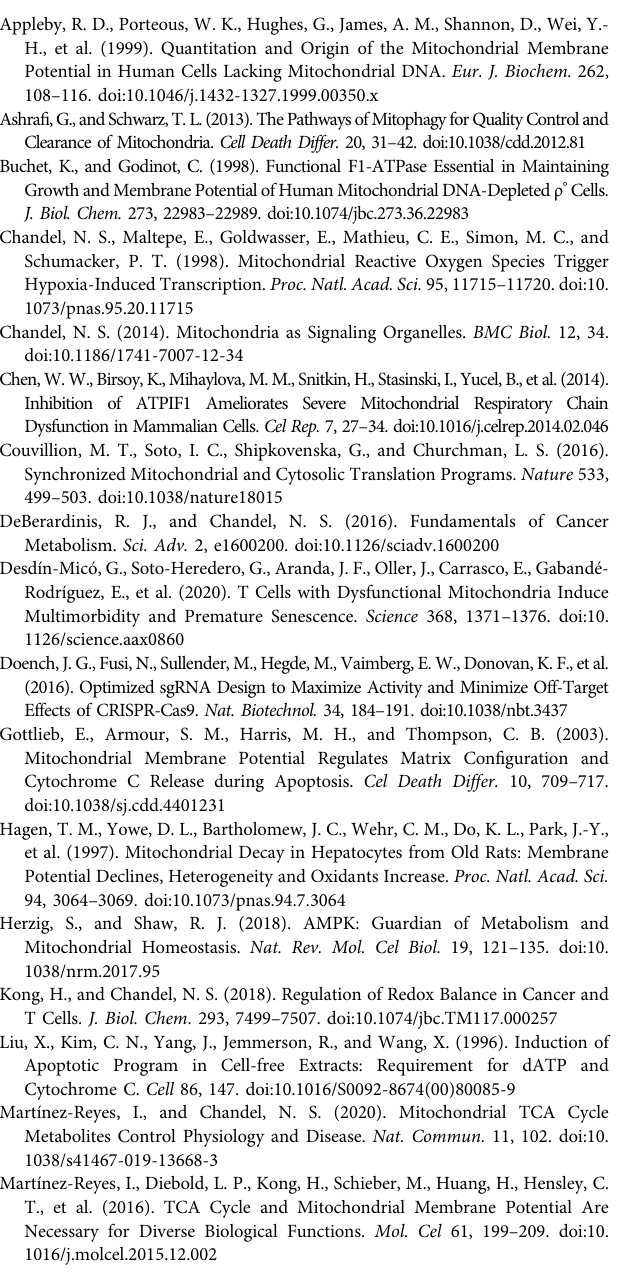
which means that the sgRNAs targeting that particular gene were found